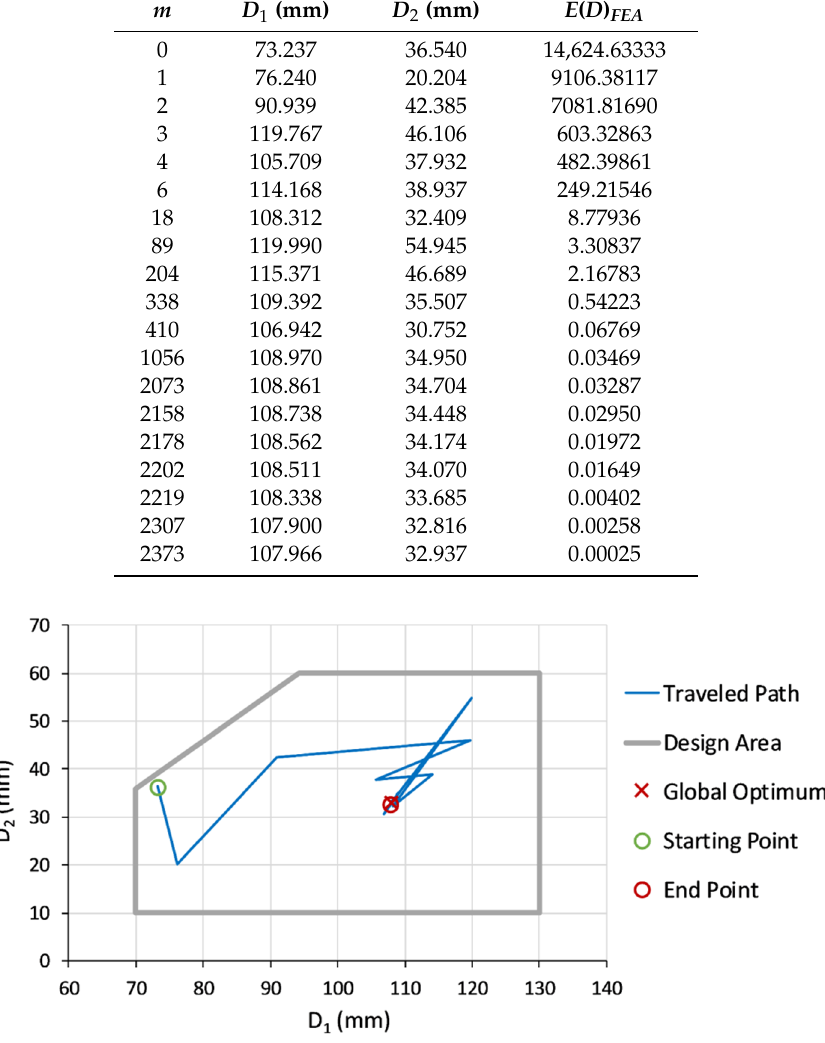
Figure 7. Investigated design points by the P-IX adjusted local search algorithm.